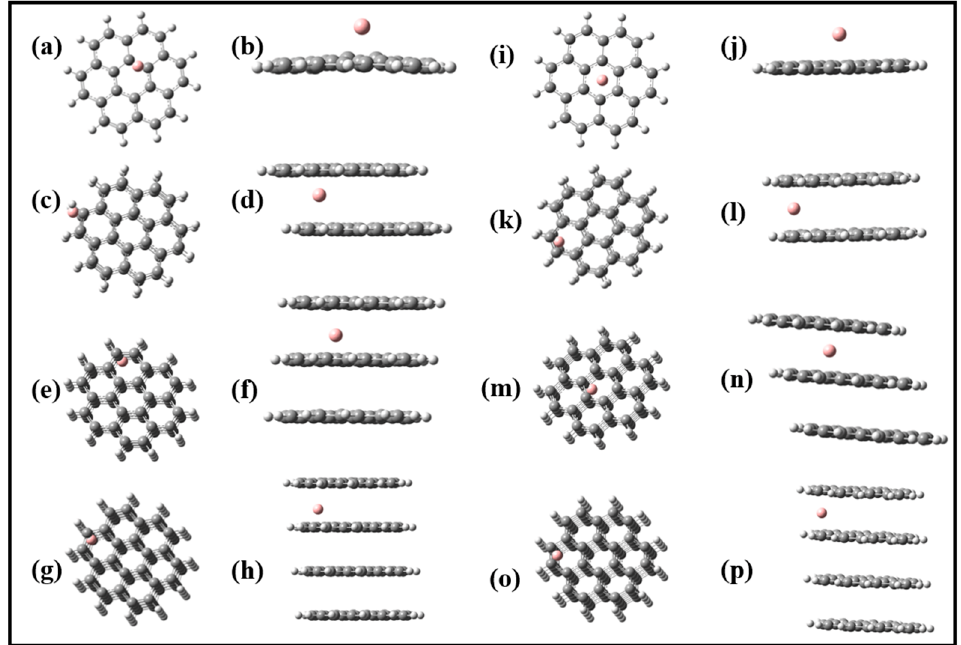
Figure 2. Optimized structures of ( a , b ) B@MG (side and top views), ( c , d ) B@BG (side and top views), ( e , f ) B@TG (side and top views), ( g , h ) B@TTG (side and top views), ( i , j ) B 3+ @MG (side and top views), ( k , l ) B 3+ @BG (side and top views), ( m , n ) B 3+ @TG (side and top views), and ( o , p ) B 3+ @TTG (side and top views).